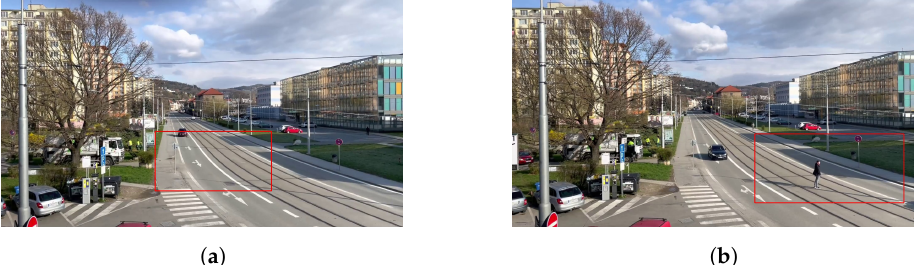
Figure 12. First frames of the Sample scenario #2. ( a ) Front view of Sample scenario #2; ( b ) rear view of Sample scenario